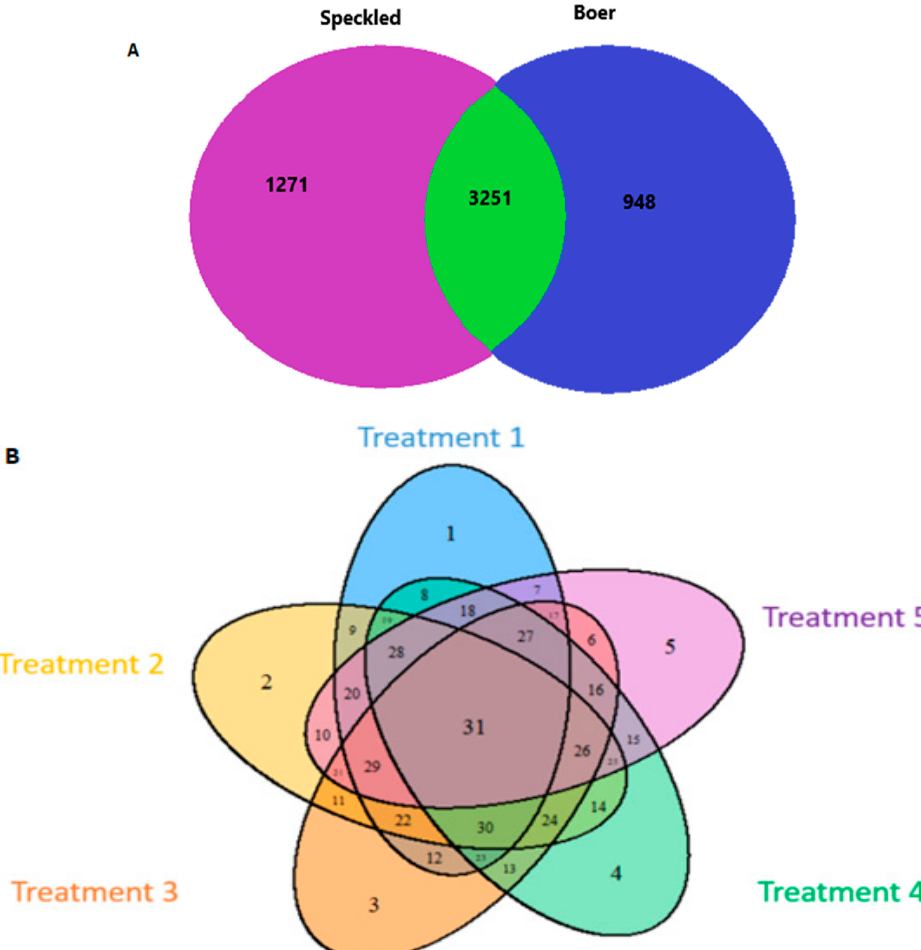
Figure 2. Venn diagram of number of operational taxonomic units of bacteria at day 30 of the trial between two goat breeds ( A ) Speckled (purple) and Boer (blue), and five treatment groups ( B ): treatment 1 (blue), treatment 2 (yellow), treatment 3 (orange), treatment 4 (green), treatment 5 (purple). The numbers in the diagrams represent how many OTUs were unique in the five treatment groups or shared (similar) between sections as their areas overlaps.